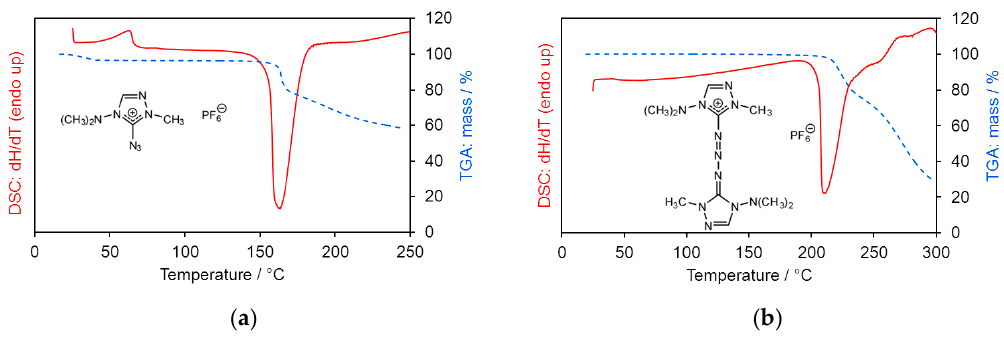
Figure 6. DSC and TGA (a) of 1 and (b) of 3 . Heating rate 10 °C·min − 1 .